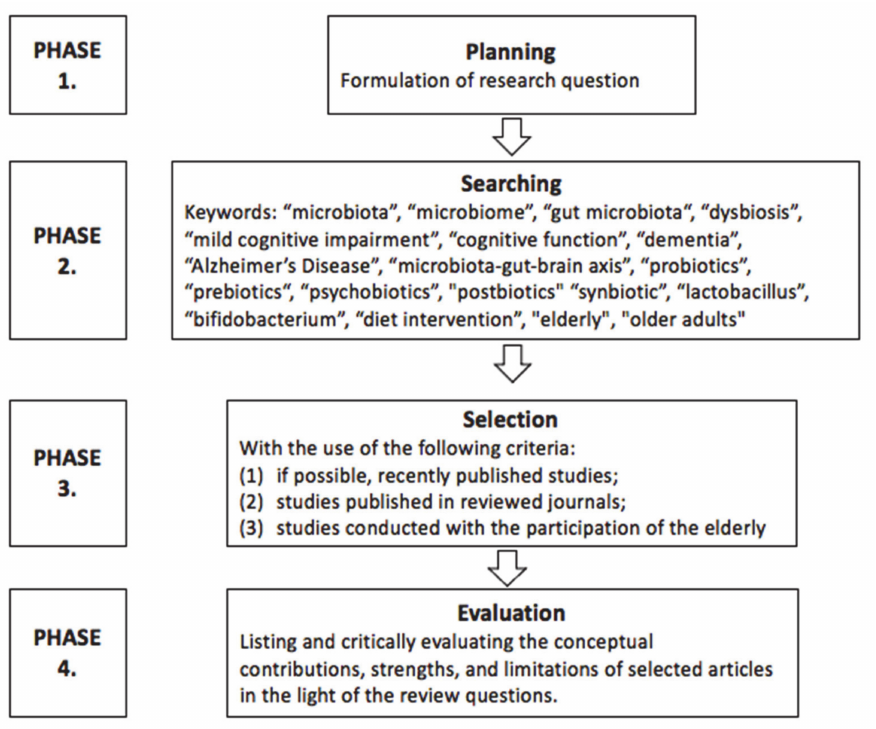
Figure 1. Diagram of review